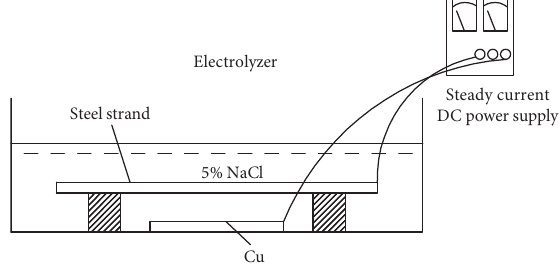
Figure 4: Electrochemical corrosion